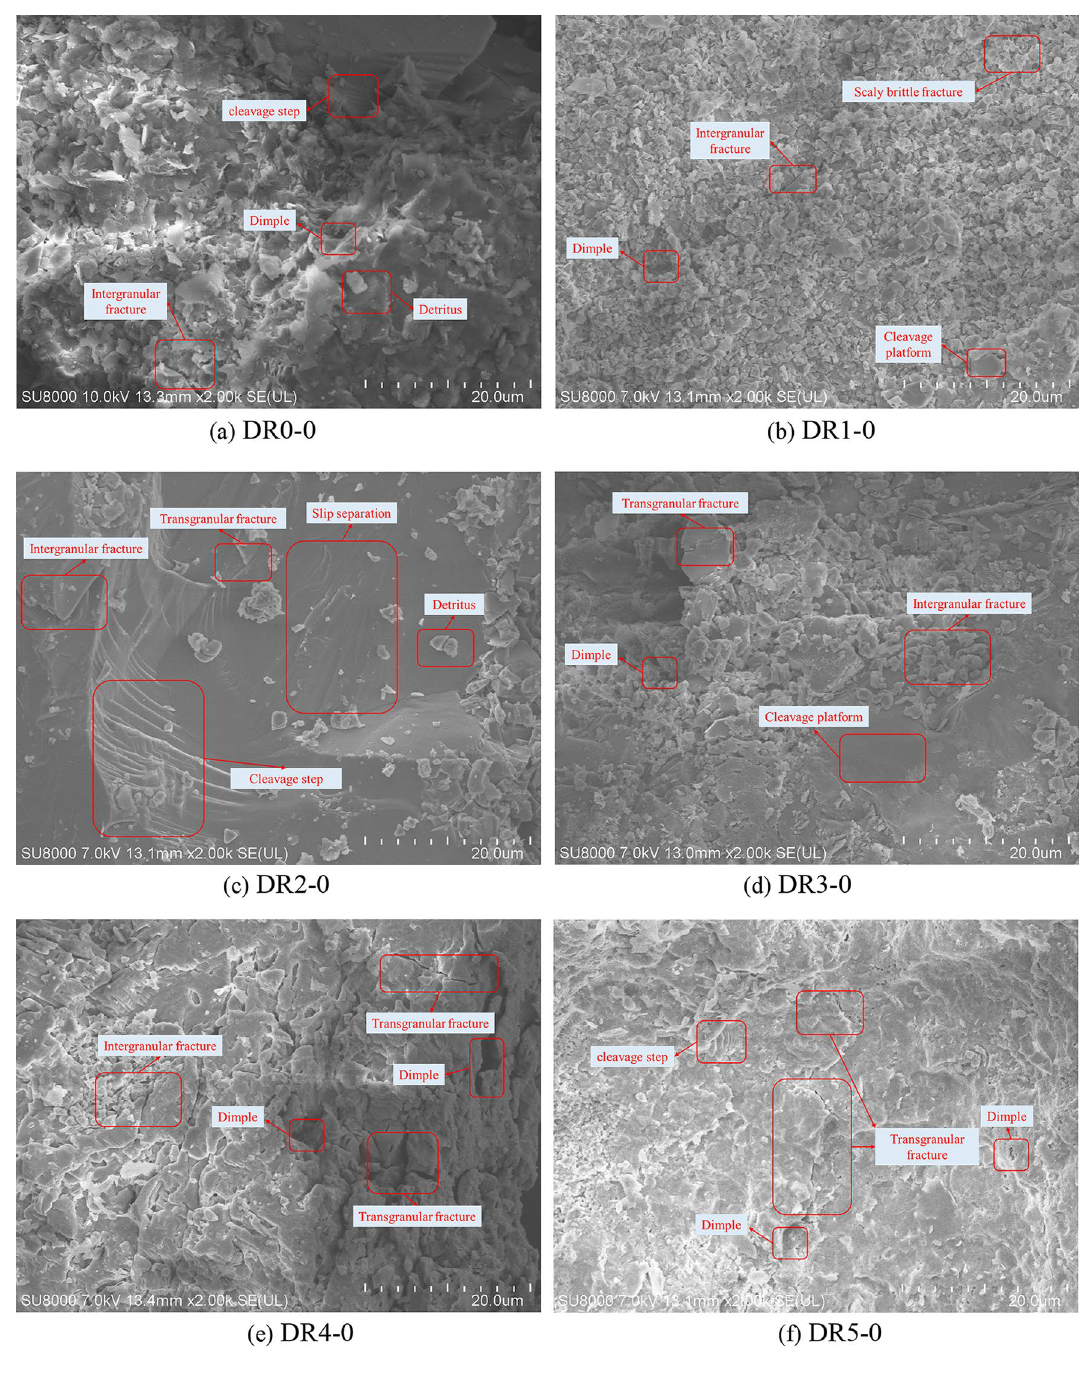
Figure 15. Mesoscopic failure structure of white sandstone